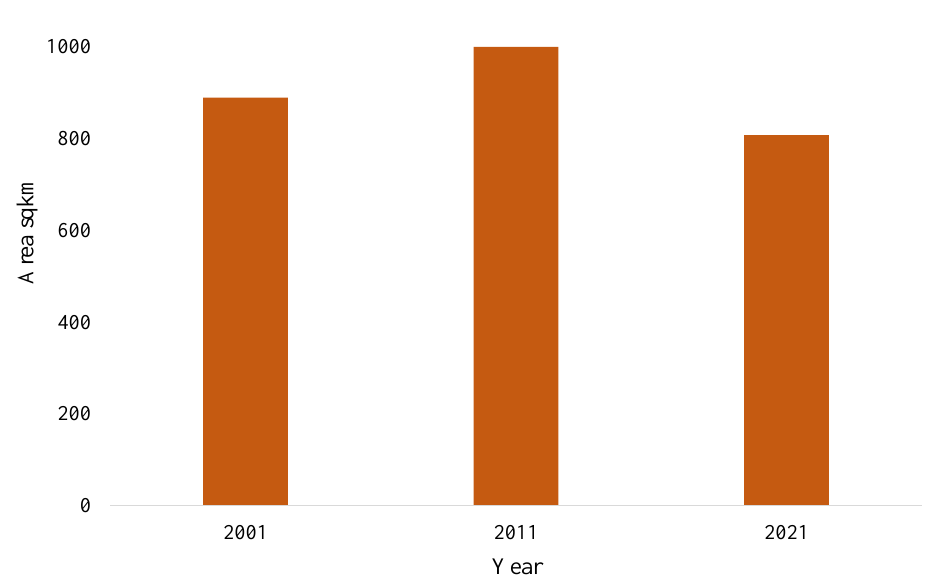
Figure 7. Column graph showing comparative change in Others category for 2001, 2011, and 2021.